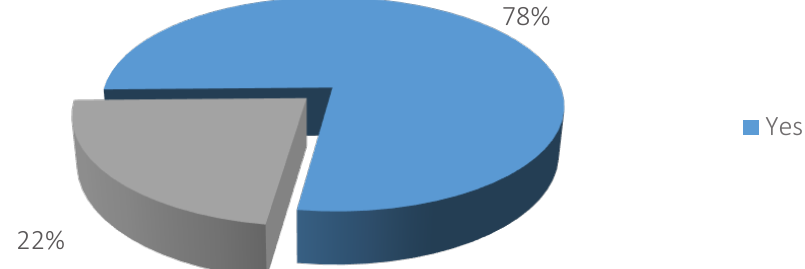
Figure 10. Reasons to choose a specific tourist destination 7 8